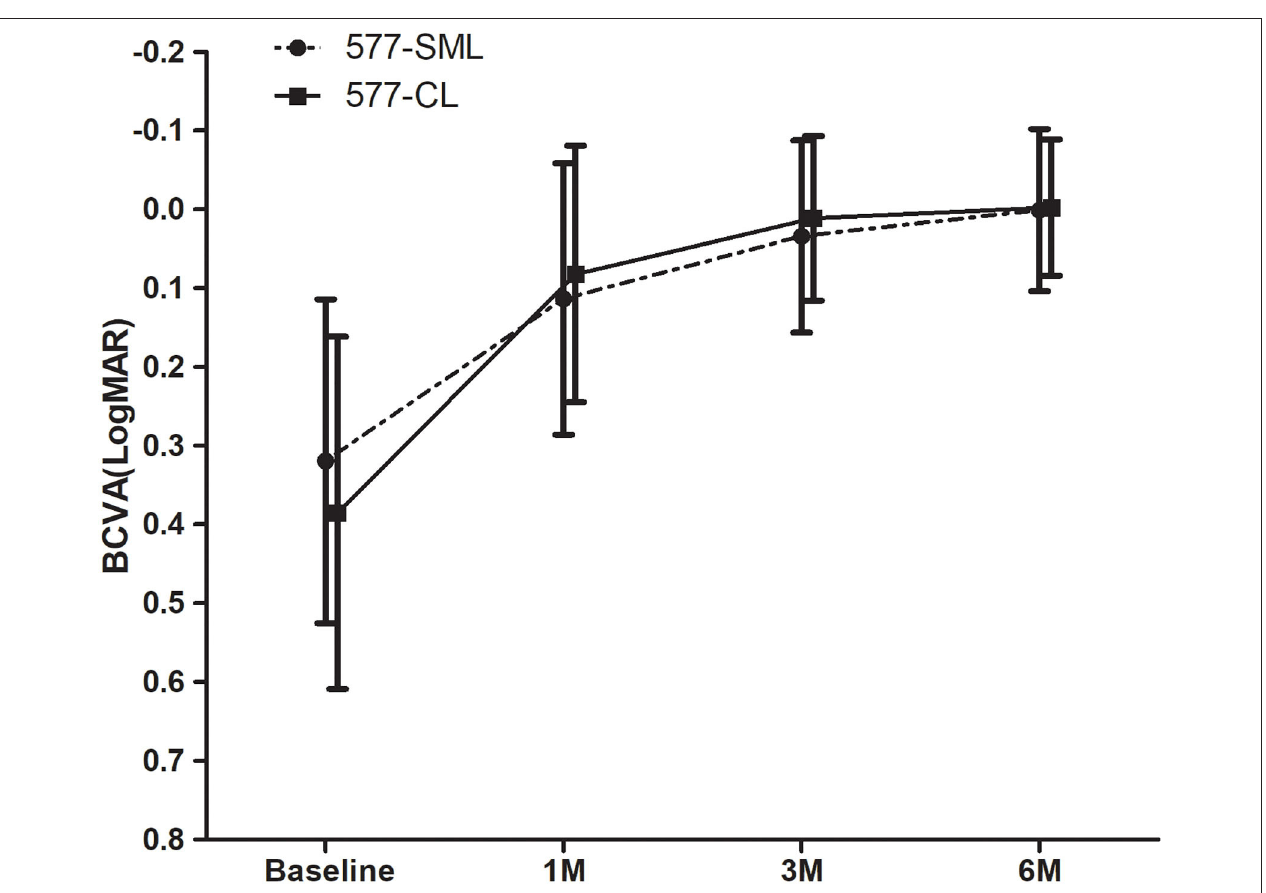
FIGURE 2 | The change of mean LogMAR-BCVA. The BCVA of all patients showed a statistically significant improvement at each visit compared with the baseline in each group ( p < 0.05). Whereas, there was no significant difference between the 577-nm SML group and the 577-nm CL group ( p > 0.05). LogMAR, logarithm of the minimum angle of resolution; BCVA, best-corrected visual acuity. SML, subthreshold micropulse laser. CL, conventional laser.